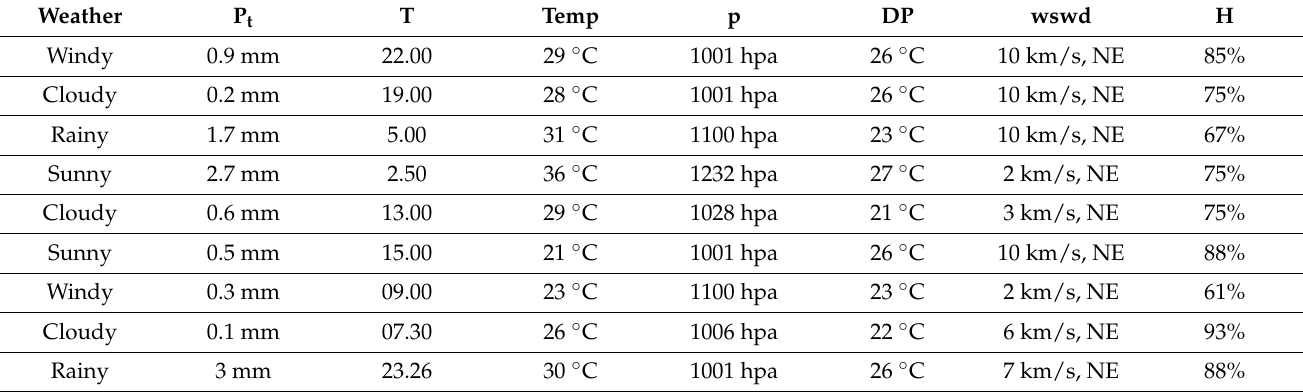
Figure 4. LGRU weather and event prediction. Table 2. Weather report for 24 h.